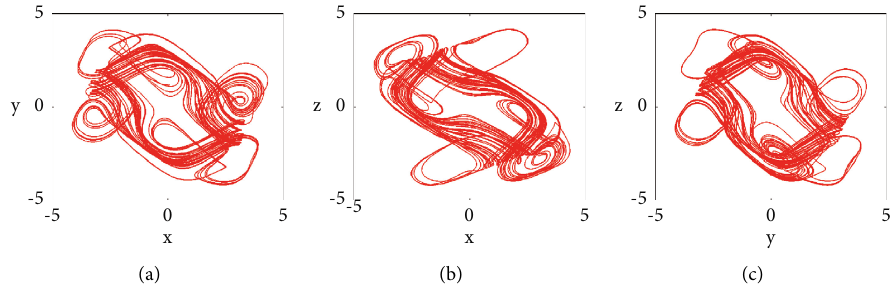
Figure 8: Chaotic attractor of system (4) when q ( x